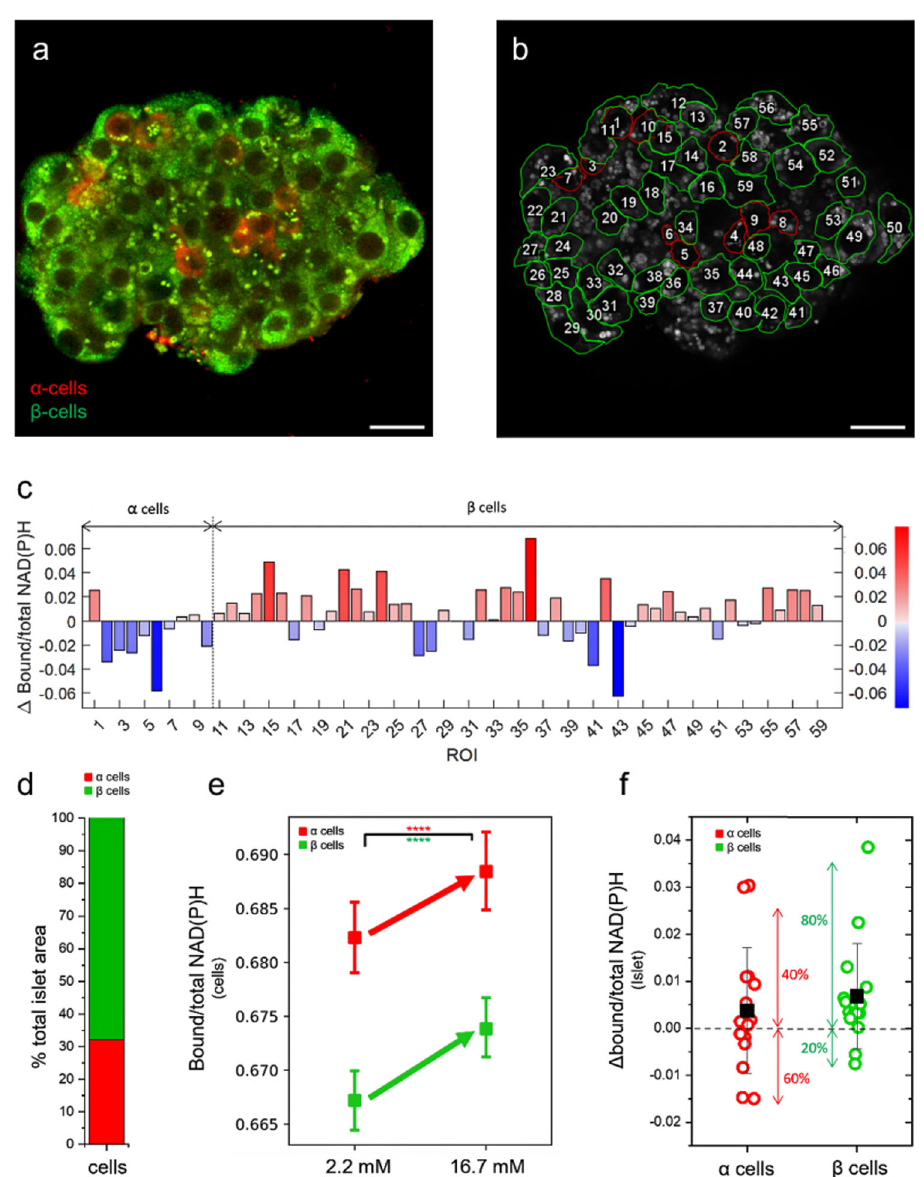
Fig. 3 From FLIM imaging to single-cell metabolism. a Immediately after 16.7 mM glucose FLIM imaging, cells are fi xed to preserve their shape and structure and then incubated with anti-glucagon and anti-insulin antibodies which in turn recognize α (red) and β -cells (green). b Comparison of 2.2 and 16.7 mM FLIM images with immuno fl uorescence image allow us to recognize cell borders and identity. At this point, single-cell segmentation occurs by tracing ROIs on the two FLIM images (here reported only the 2.2 mM as representative image). Each segmented cell has a unique and equal ROI number in both 2.2 and 16.7 mM FLIM images. Then, single-cell barycenter are calculated, converted in Bound/total NAD(P)H ratio and their difference between 2.2 and 16.7 mM state determines the single-cell metabolic shifts ( c ). Each cell ROI represents a single cell with red bars indicating bound-shift and blue ones free-shift. d Considering all the segmented cells, the relative abundance of α (~30%) and β cells (~70%) is in keeping with literature 3 and their average response is bound-shifted for both cell types ( e ), in apparent contrast with literature. f If single-cell metabolic shifts are averaged at islet level, α cells ( n = 312 cells from 15 islets obtained by 4 different donors) show shift towards free NAD(P)H in 60% of islets with the remaining 40% shifting towards bound NAD(P)H; by contrast, for what concerns β cells ( n = 654 cells from 15 islets obtained by 4 different donors), approximately 80% of the islets display a metabolic shift towards bound NAD(P)H and only the remaining 20% towards free NAD(P)H. Statistical difference obtained using Paired Samples Wilcoxon Test, with signi fi cance α = 0.05 (**** P < 0.0001). Scale bar: 20 μ